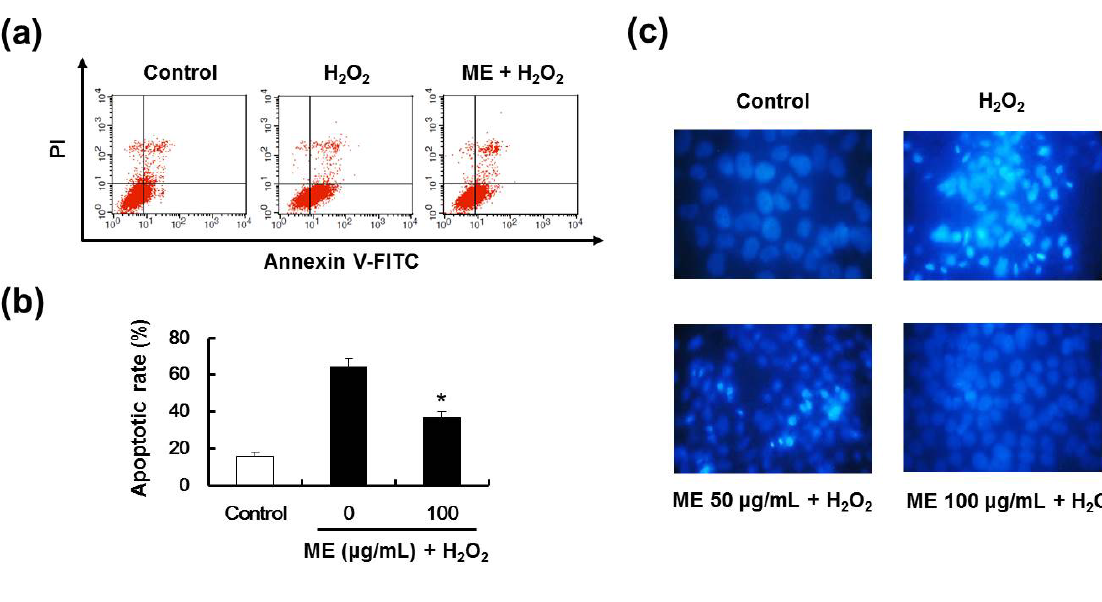
Figure 5. Effect of ME on hydrogen peroxide-induced apoptosis in pancreatic MIN6N cells. MIN6N β -cells were pre-incubated with different concentrations of ME for 20 h and then 0.7 mM hydrogen peroxide was added to all cells for 4 h, with the exception of the control group. ( a ) Apoptotic cells were detected by Annexin V and PI double staining and analyzed by flow cytometry. ( b ) The percentage of apoptotic-cell death from upper right plus lower right quadrants. Data represent the mean ± SE of three independent